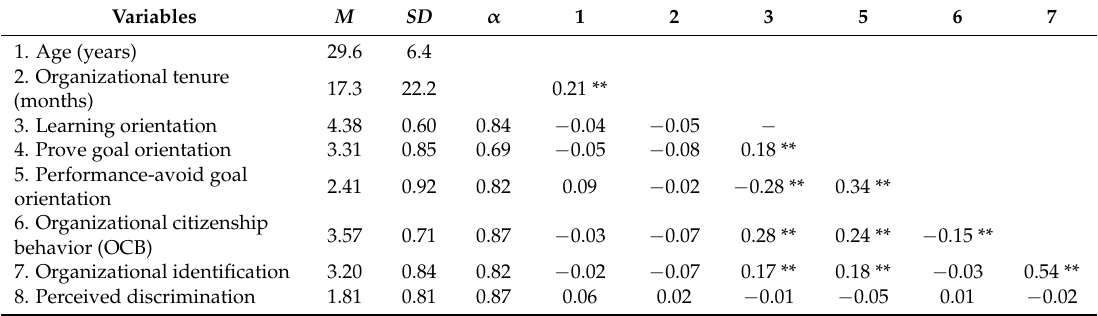
Table 1. Descriptive statistics and correlation matrix ( N =